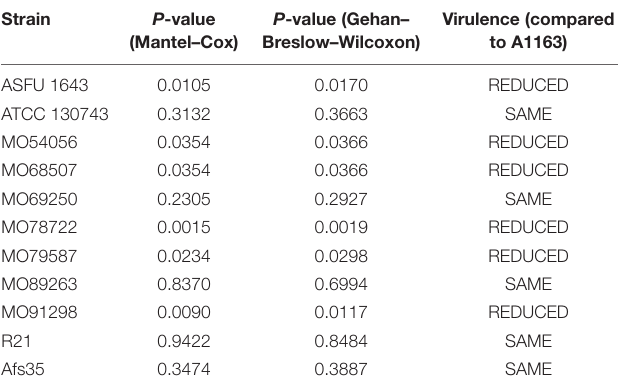
TABLE 2 | Virulence data of clinical isolates when compared to A1163 in a neutropenic BALB/c murine model of invasive aspergillosis. Strain